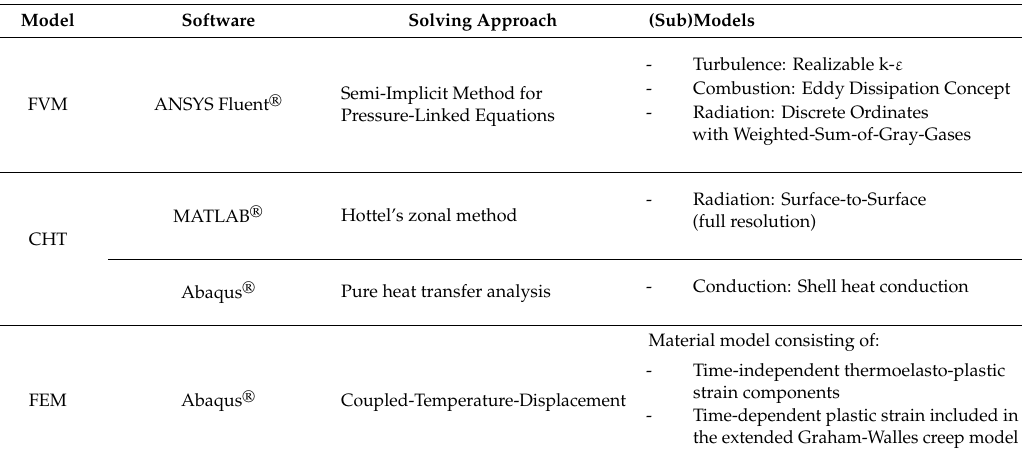
Table 2. Outline of the FVM, CHT, and FEM